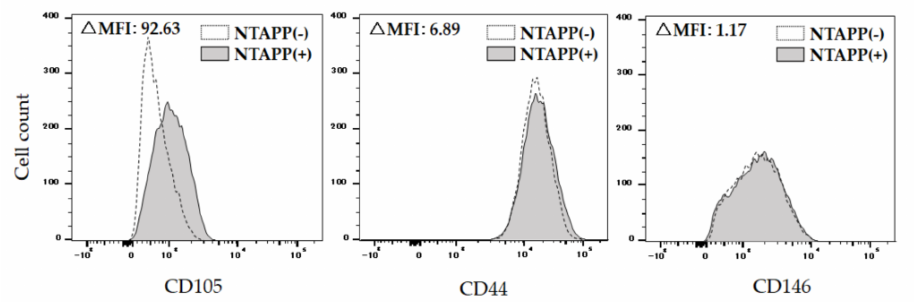
Figure 5. Effect of non-thermal atmospheric pressure plasma (NTAPP) on the expression of stem cell-specific markers (CD44, CD105, and CD146) in human deciduous dental pulp fibroblast-like cells (hDDPFs). ∆ MFI (%), change in median fluorescence